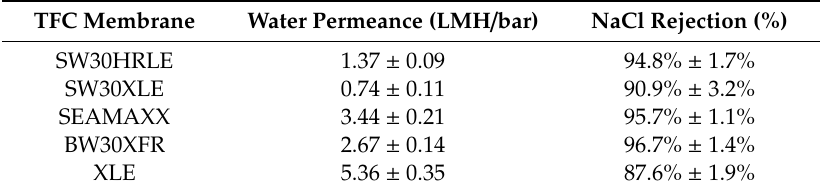
Table 1. Measured transport properties of the TFC membranes before contact with alcohol. Error represents one standard deviation among at least 25